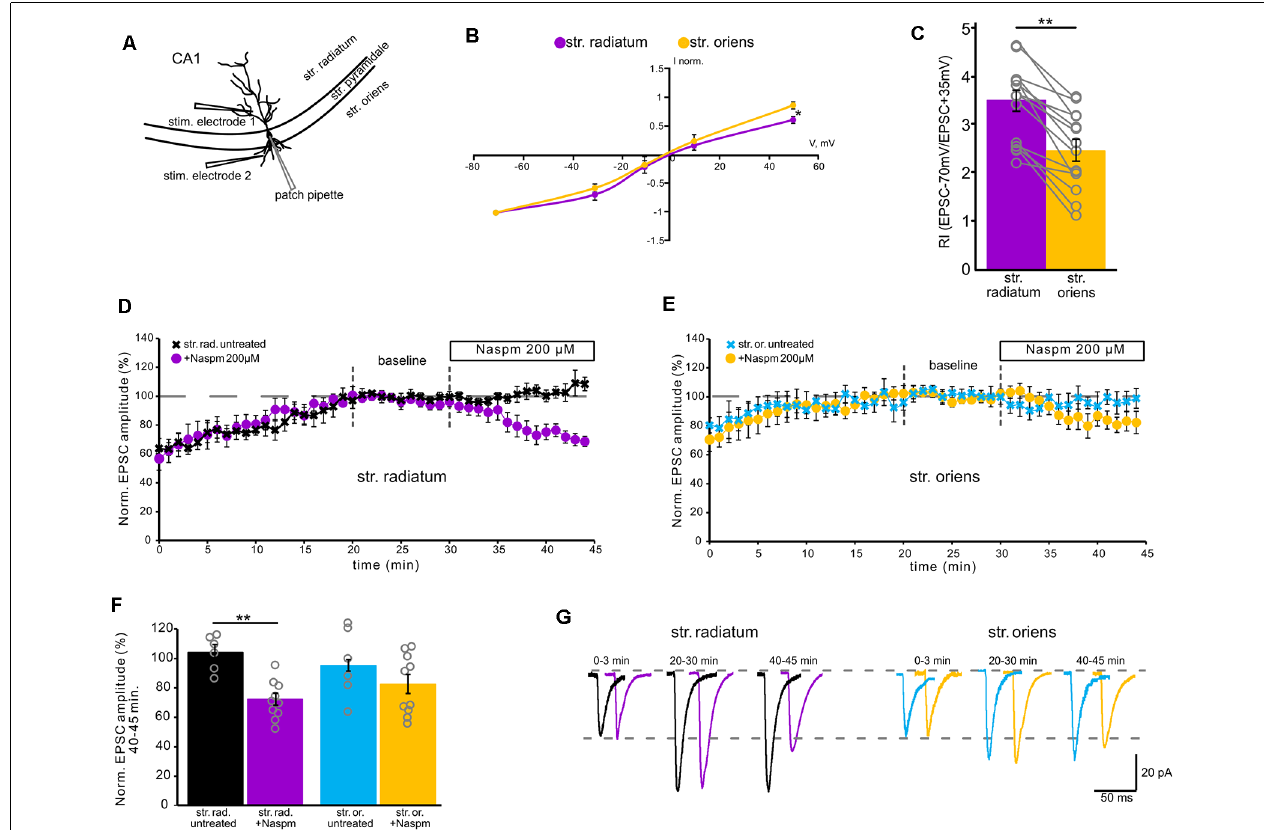
FIGURE 1 | Contribution of calcium-permeable AMPA receptors to synaptic transmission. (A) A schematic representation of the location of the stimulating electrode. (B) Current–voltage characteristics of apical (purple) and basal (orange) inputs. n = 7 cells from four animals, * p ≤ 0.05. (C) Comparison of rectification indices in stratum radiatum (purple) and stratum oriens (orange). Open gray circles represent individual data points, n = 14 cells from nine animals, ** p ≤ 0.005. (D) The time course of averaged EPSC amplitude changes at apical inputs during washout of polyamine (black, n = 6 cells from three animals) and subsequent Naspm (200 µ M) application (purple, n = 10 cells from eight animals), when CA1 pyramidal neurons were dialyzed with a polyamine-free intracellular solution. For analysis, 10 successive responses were averaged and normalized to the mean EPSC amplitude obtained between the 20th and 30th minutes of the recording session (baseline marked with gray dashed lines). (E) The same time course as (D) but for basal inputs. Blue, untreated cells, n = 6 cells from five animals. Orange, cells treated with Naspm (200 µ M), ( n = 10 cells from eight animals). (F) A histogram demonstrating normalized EPSCs for the last 5 min of the curves D and E. Open gray circles represent individual data points, ** p ≤ 0.005. (G) Representative averaged traces at the indicated times of the curves D and E are shown in black and purple for apical dendrites, and in blue and orange for basal